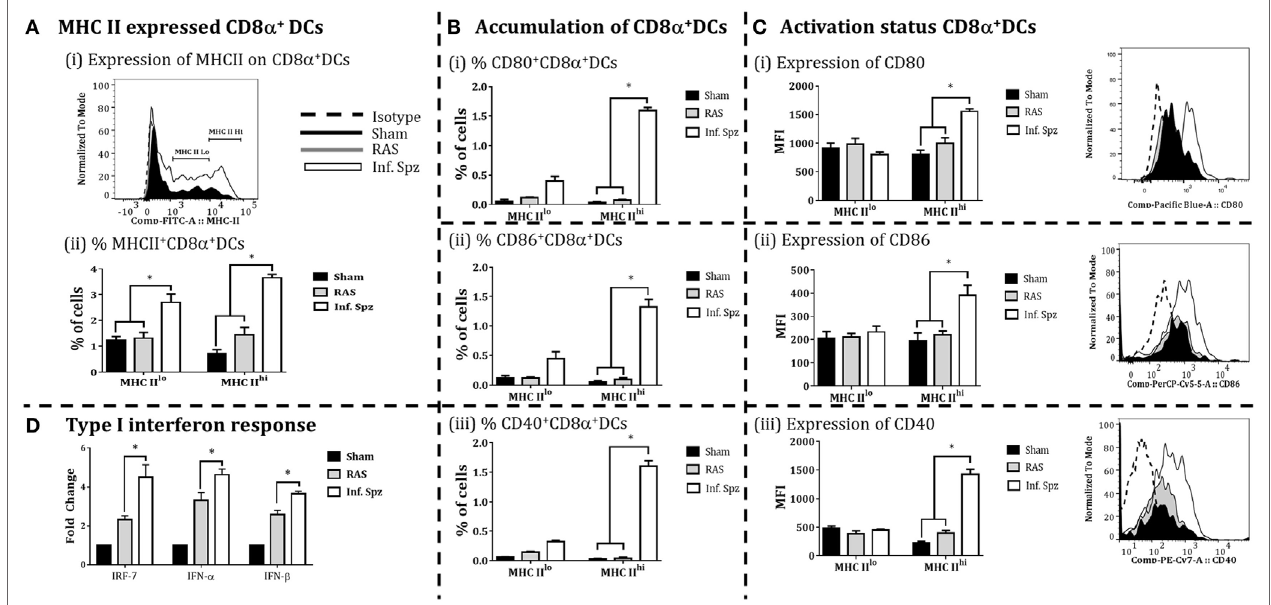
FigUre 4 | CD8 α + dendritic cells (DCs) expressed the MHC class II (I-A b ) and costimulatory molecules; CD80, CD86, and CD40 in the liver. (a) Percent CD8 α + DCs with MHC-II high (MHCII hi ) and MHC-II low (MHCII lo ) accumulated in the liver and histogram showing MHC-II expression on CD8 α + DCs. (B) Accumulation of CD8 α + DCs with the expression of (i) CD80, (ii) CD86, and (iii) CD40. The graphs present the percent cells out of total mononuclear cells. (c) The expression of (i) CD80, (ii) CD86, and (iii) CD40 measured as the mean fluorescent intensity (MFI) on CD8 α + DCs ( left panels ) in the liver. The right panels show histogram for the expression of CD80, CD86, and CD40 on MHC-II hi CD8 α + DCs in the liver. (D) Measurement of the interferon response (IRF-7, IFN- α , and IFN- β ) in radiation-attenuated sporozoites (RAS) or infectious sporozoites (Inf. Spz) inoculated mice through qPCR. The expression of β -actin gene in individual sample was used as an internal control for each mouse. Data are expressed as the fold induction of the gene of interest in the different activation conditions compared with sham control group. Data are the mean ± SEM. The data were analyzed with non-parametric Mann–Whitney U -test. p < 0.05 is considered as a significant. Data shown represent one of two independent